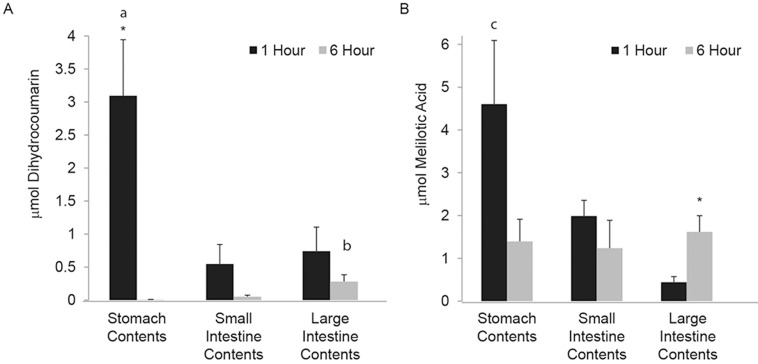
DHC and MA are present in intestinal contents.DHC (a) and MA (b) were extracted from the contents of the stomach, large intestine, and small intestine, and analyzed by HPLC as outlined Materials and methods. *More DHC was present in the stomach contents at 1 hr vs. 6 hr (p = 0.015) and more MA was present in the large intestine contents at 6 hr vs. 1 hr (p = 0.03); a More DHC was present in stomach contents at 1 hr compared to large and small intestine contents at 1 hour (p = 0.0097); b more DHC was present in large intestine contents at 6 hr compared to stomach and small intestine contents at 6 hr (p = 0.014); and c more MA in was present in stomach contents at 1 hr compared to large intestine contents at 1 hr (p = 0.015). AVG ± SE, n = 6.